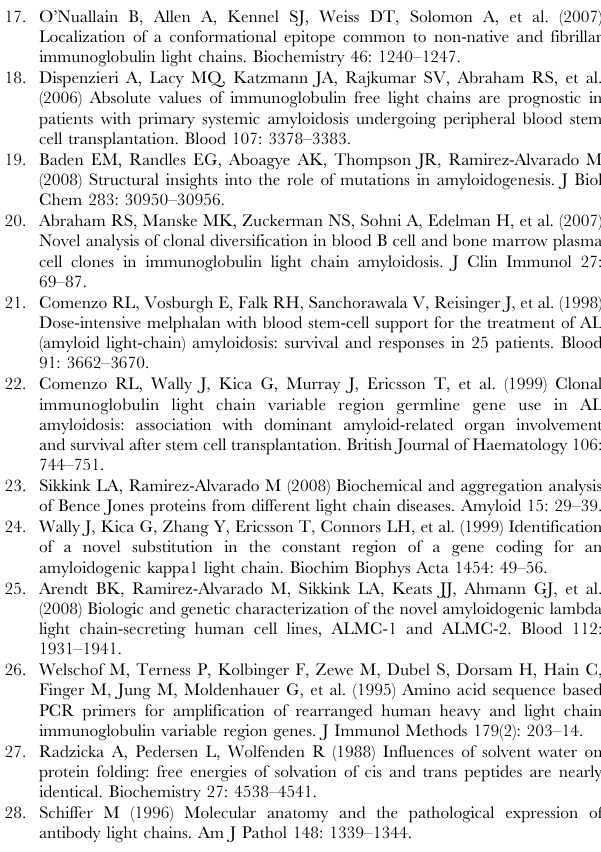
Figure S5 Sequence alignment of AL V l VI 6a. Structure determination and mutation analysis were done as described in Figure S1. Found at: doi:10.1371/journal.pone.0005169.s005 (1.09 MB TIF) Figure S6 Sequence alignment of Normal Control V k I L12, 012/02, L5, V k II A19, A1, V k III A27 and L2. Structure determination and mutation analysis were done as described in Figure S1. Found at: doi:10.1371/journal.pone.0005169.s006 (0.81 MB TIF) Figure S7 Sequence alignment of Normal Control V k III L6 and L2 V k IV B3. Structure determination and mutation analysis were done as described in Figure S1. Found at: doi:10.1371/journal.pone.0005169.s007 (0.42 MB TIF) Figure S8 Sequence alignment of Normal Control V l I 1c, 1b, V l II 2a2, 2e, V l III 3h, V l VII 7b and V l IX 9a. Structure determination and mutation analysis were done as described in Figure S1. Found at: doi:10.1371/journal.pone.0005169.s008 (0.59 MB TIF) Figure S9 Sequence alignment of Multiple Myeloma Control V l VI 6a, V l III 3r, V l II 2a2, V k I 018/08, L12, V k II A19, and V k IV B3. Structure determination and mutation analysis were done as described in Figure S1.